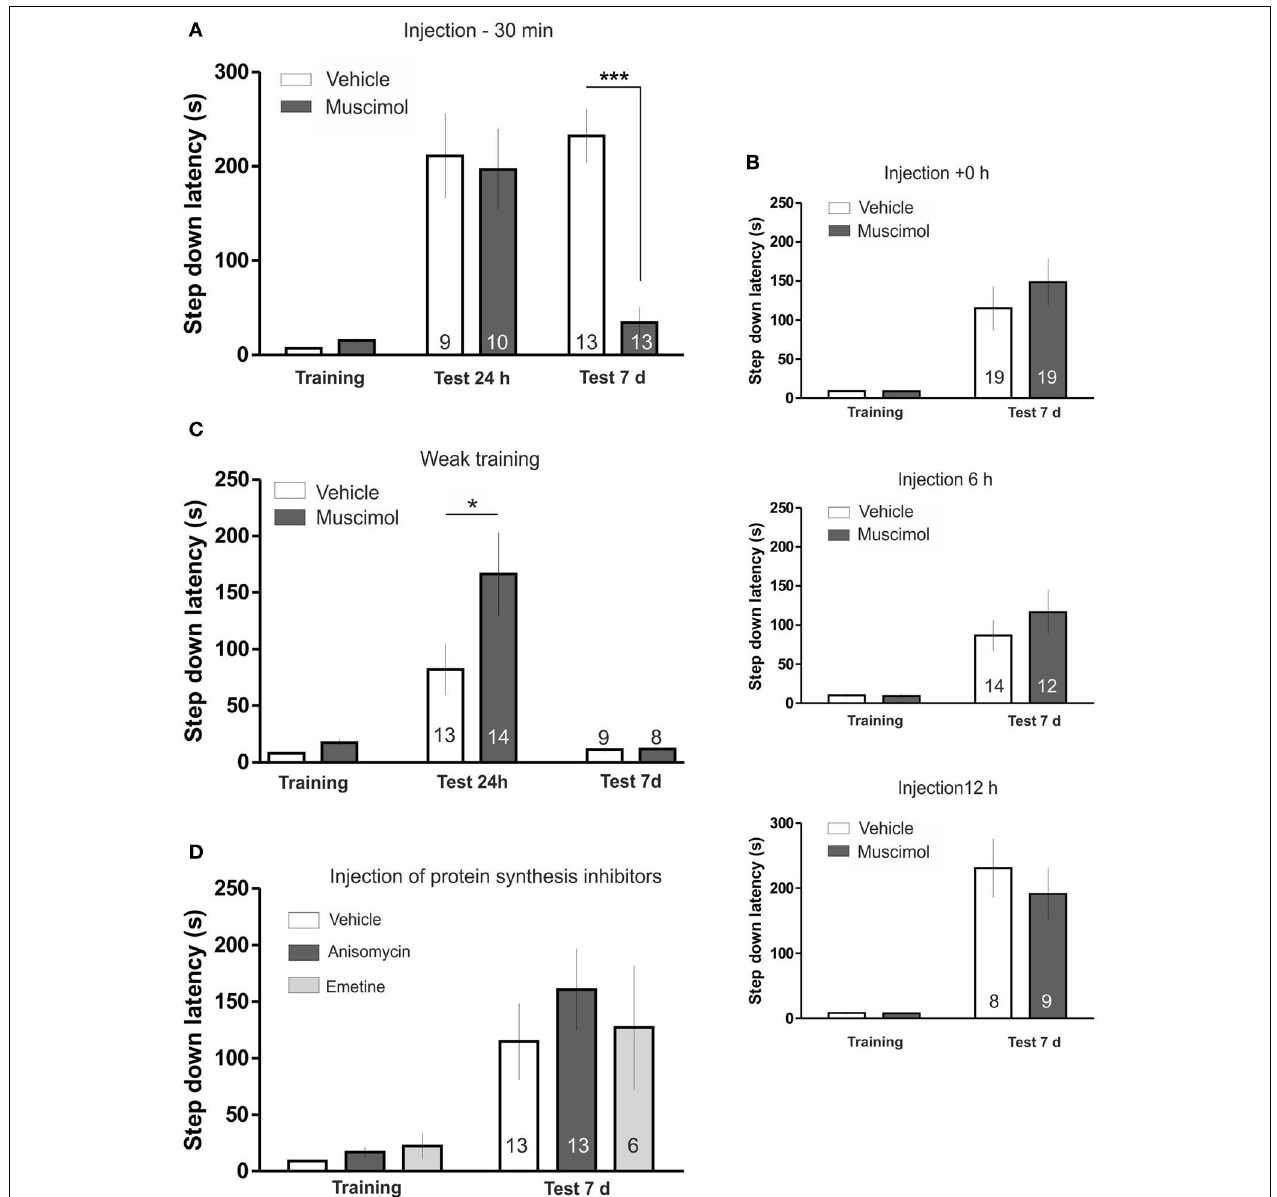
FIGURE 1 | (A) LHb inactivation disrupts temporal stability of IA memory. Animals were trained in the IA 30min after injection of muscimol or vehicle (saline) in the LHb. Muscimol injection did not affect memory retention in the 24h tested group but induced a clear memory impairment in the 7 days tested group. (B) Top: Injection of muscimol immediately after IA training did not induce amnesia. Centre: Injection of muscimol 6h after IA training did not induce amnesia. Bottom: Injection of muscimol 12h after IA training did not induce amnesia. (C) Temporal